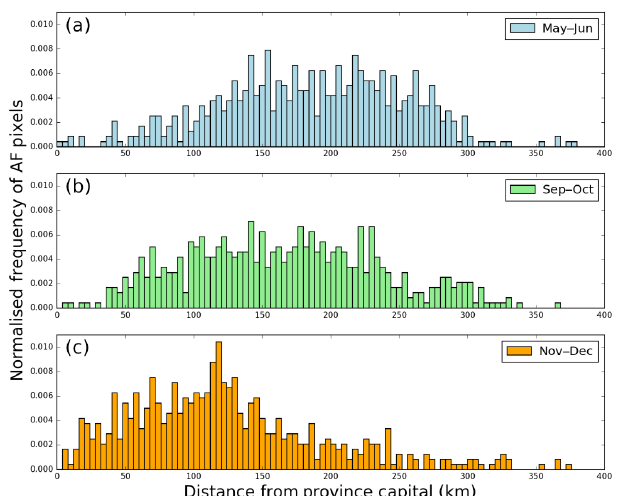
Figure 13. Normalised frequency distribution of distance from the province capital for the top 10% of high FRE VIIRS-IM/Him prod- uct 0.1 ◦ grid cells during the three burning seasons: summer – May to June ( a , blue), autumn – September to October ( b , green), and winter – November to December ( c , orange). A clear shift towards the origin can be observed in the November–December period com- pared with